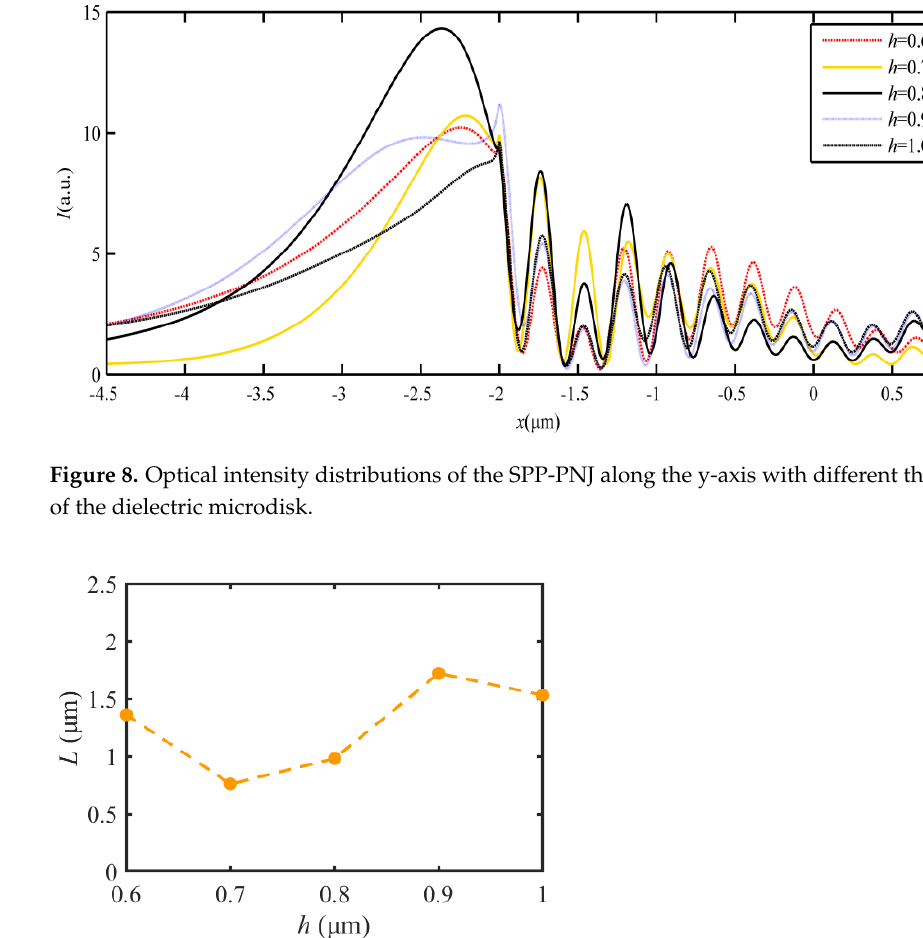
Figure 9. Comparison of the propagation distance L of the SPP − PNJ with different thicknesses h of the dielectric microdisk.